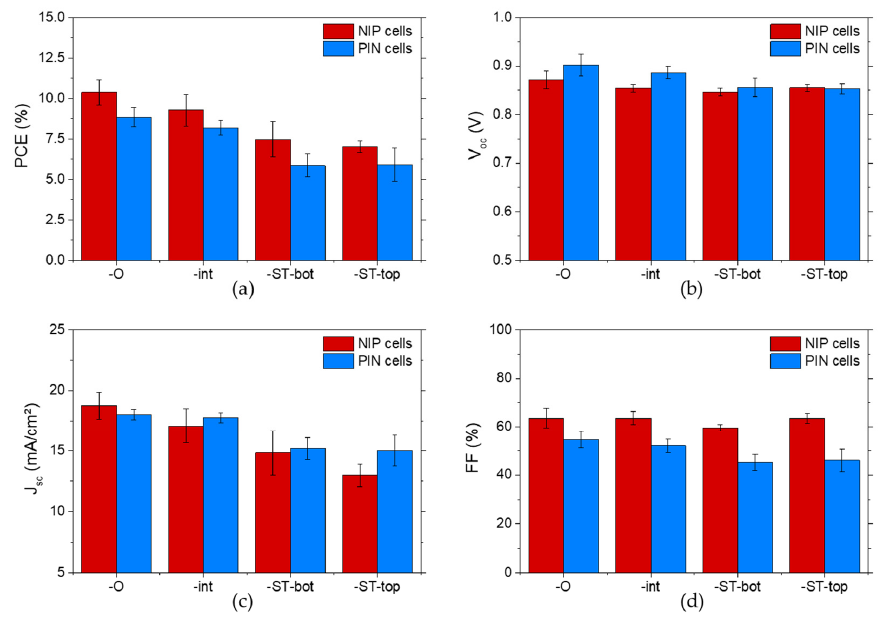
Figure 5. Averages and standard deviations of J–V data: ( a ) PCE; ( b ) V oc ; ( c ) J sc ; ( d ) FF for NIP- (dark red) and PIN-type (light blue) PSCs of each kind (opaque, intermediate and semi-transparent cells) as well as depending on the illuminated side (“-bot” and “-top” for glass and metal side, respectively). Measurements were done in reverse scan mode with an illuminated area of 0.131 cm 2 , and J–V results for both NIP- and PIN-type architectures are given for campaigns of about ten cells in total for each device type with indium tin oxide (ITO) and about twenty cells in total without ITO.